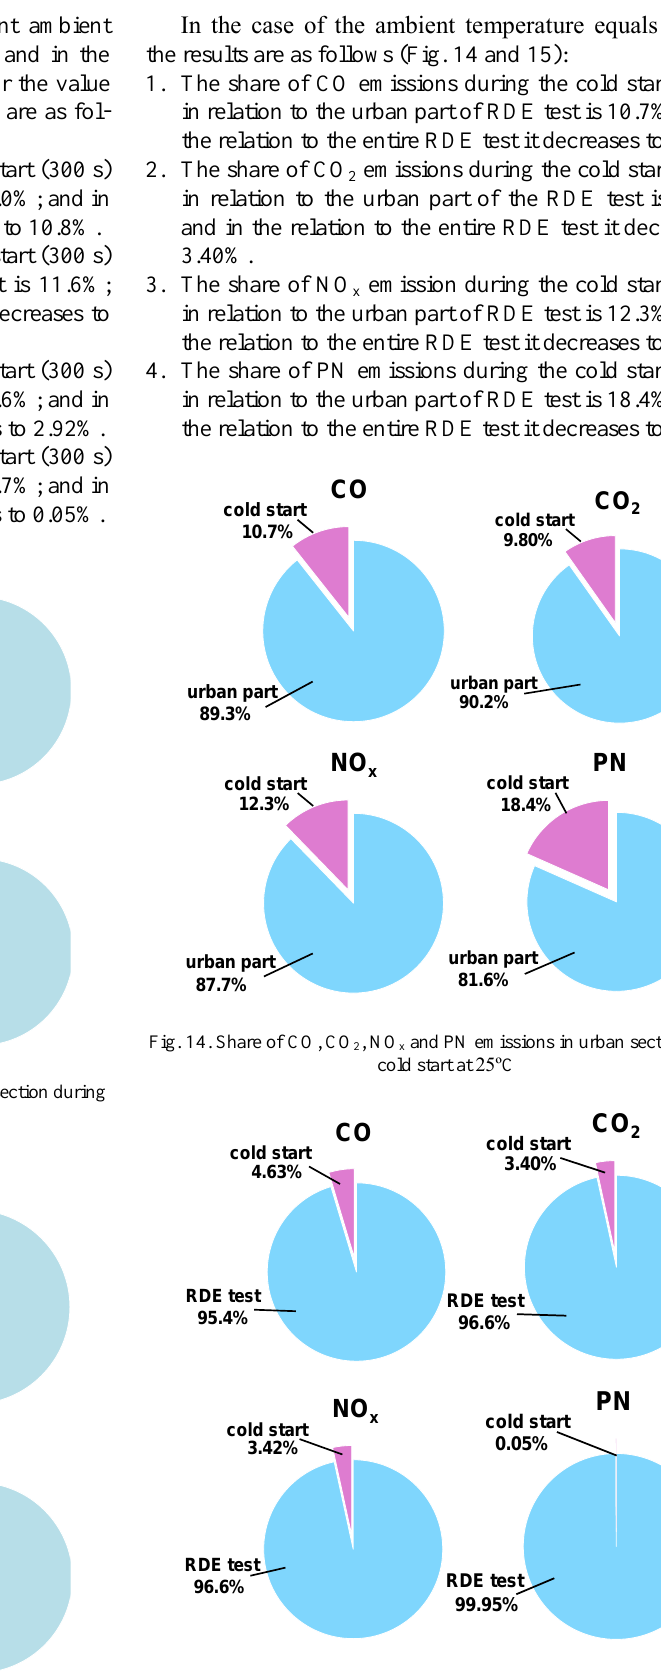
Fig. 15. Share of CO, CO 2 , NO x and PN road emissions in the entire RDE test during cold start at